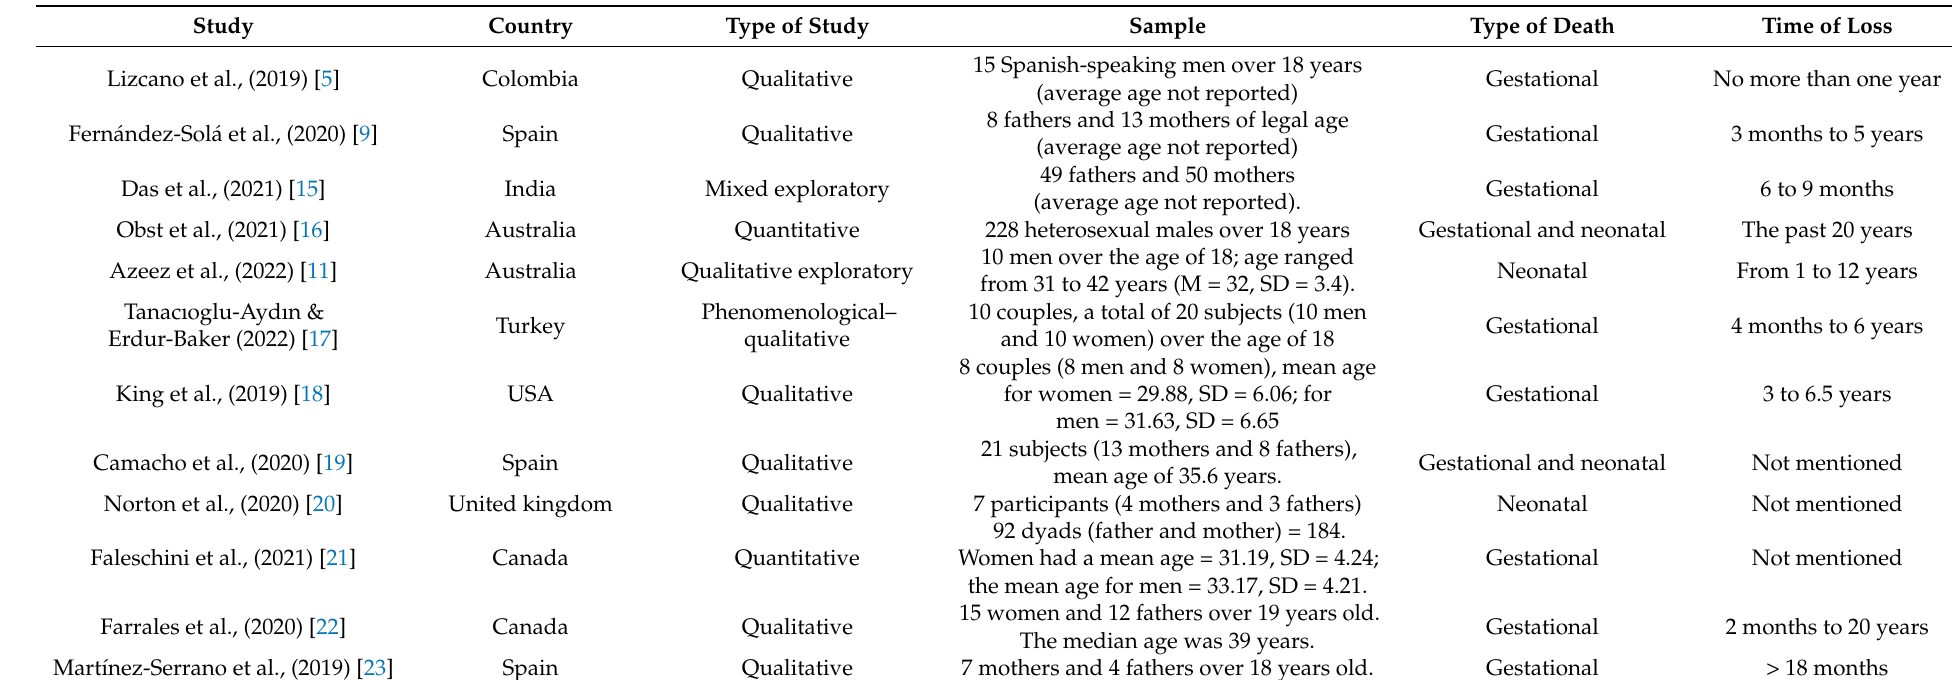
Table 1. Characteristics of the